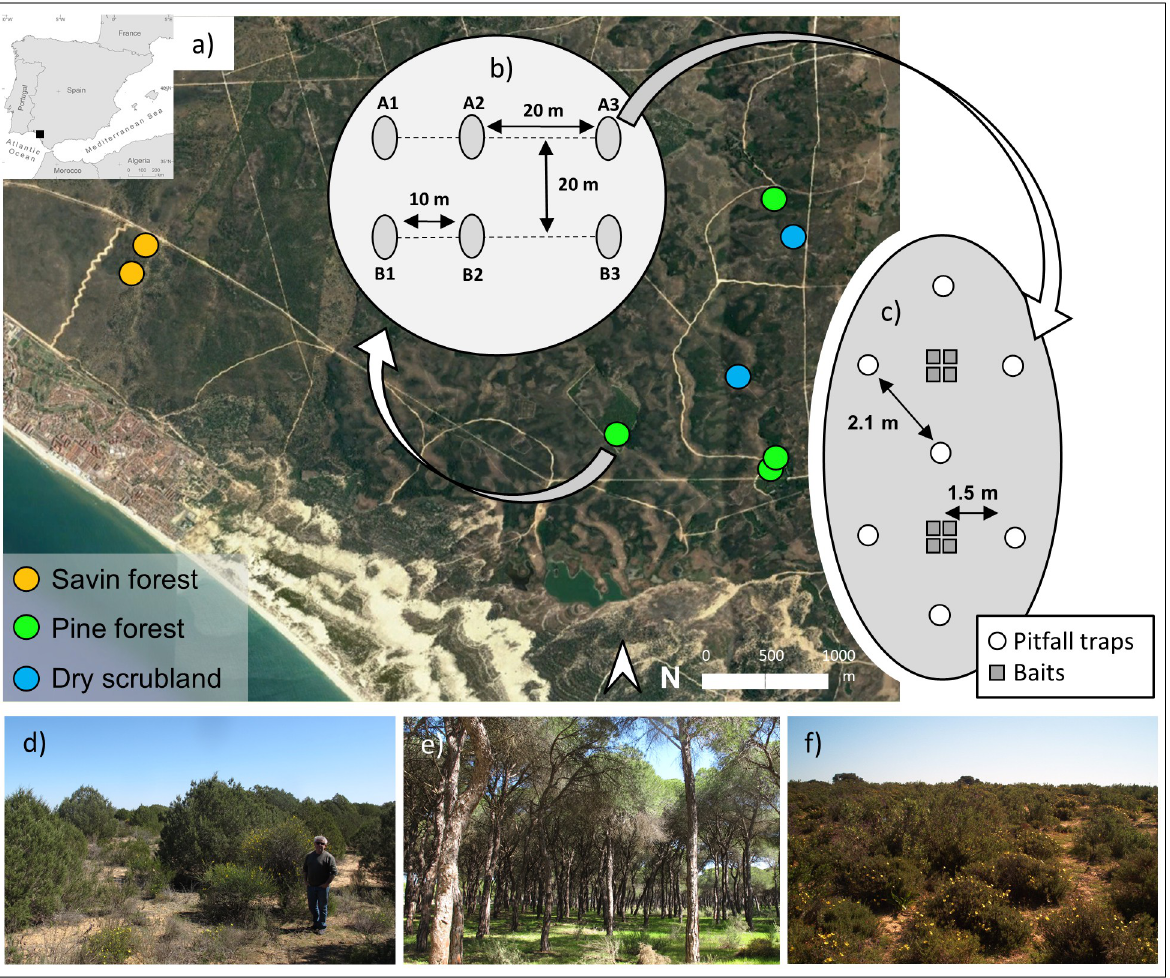
Fig 1. Study area and sampling design: (a) aerial view of the study area (Do ñ ana Biological Reserve, SW Spain) showing sampling plot site for each habitat type; (b) schema of the two sampling transects (A and B), each transect consists of three sampling points; (c) each sampling point has 7 pitfall traps (white circles) and 8 baits (grey squares); d) savin juniper forest; e) pine forest; f) dry scrubland. Aerial view from digital aerial orthophotograph of the Spanish National Orthophoto Program (PNOA) (September 2019) under a CC BY 4.0 License (https://www.ign.es/wms-inspire/pnoa-ma? and free download through the CNIG’s download